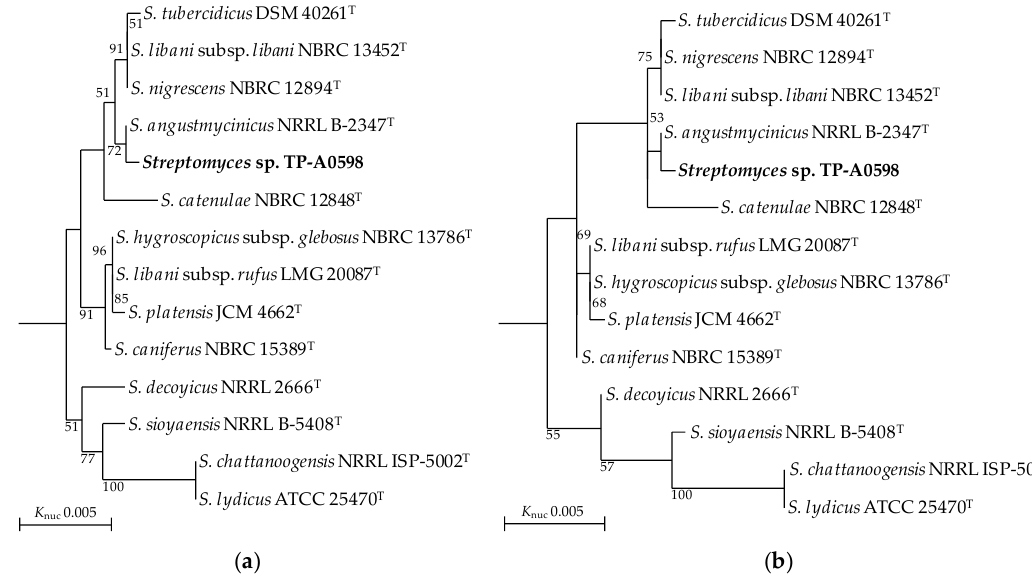
Figure 1. Phylogenetic trees of Streptomyces sp. TP-A0598 and type strains of the related species based on 16S rDNA sequences. ( a ) The neighbour-joining method; ( b ) the maximum likelihood method. Numbers on branches are the confidence limits estimated using bootstrap analysis with 1000